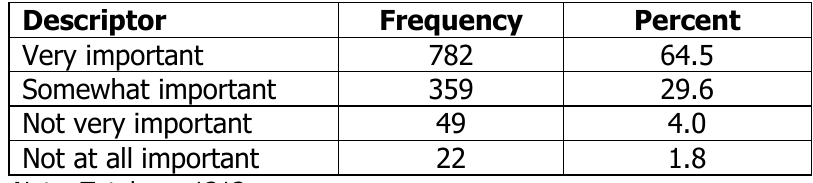
Frequency and percent values for perceptions of importance of youth participation in non-school programs Descriptor